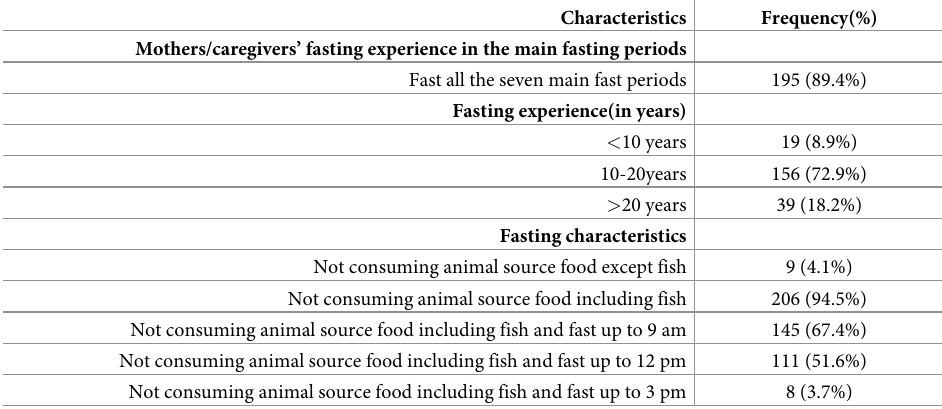
Table 2. Fasting characteristics of the mother/care giver at end line (during fasting period) in Debrebirhan town, North Shewa Ethiopia,